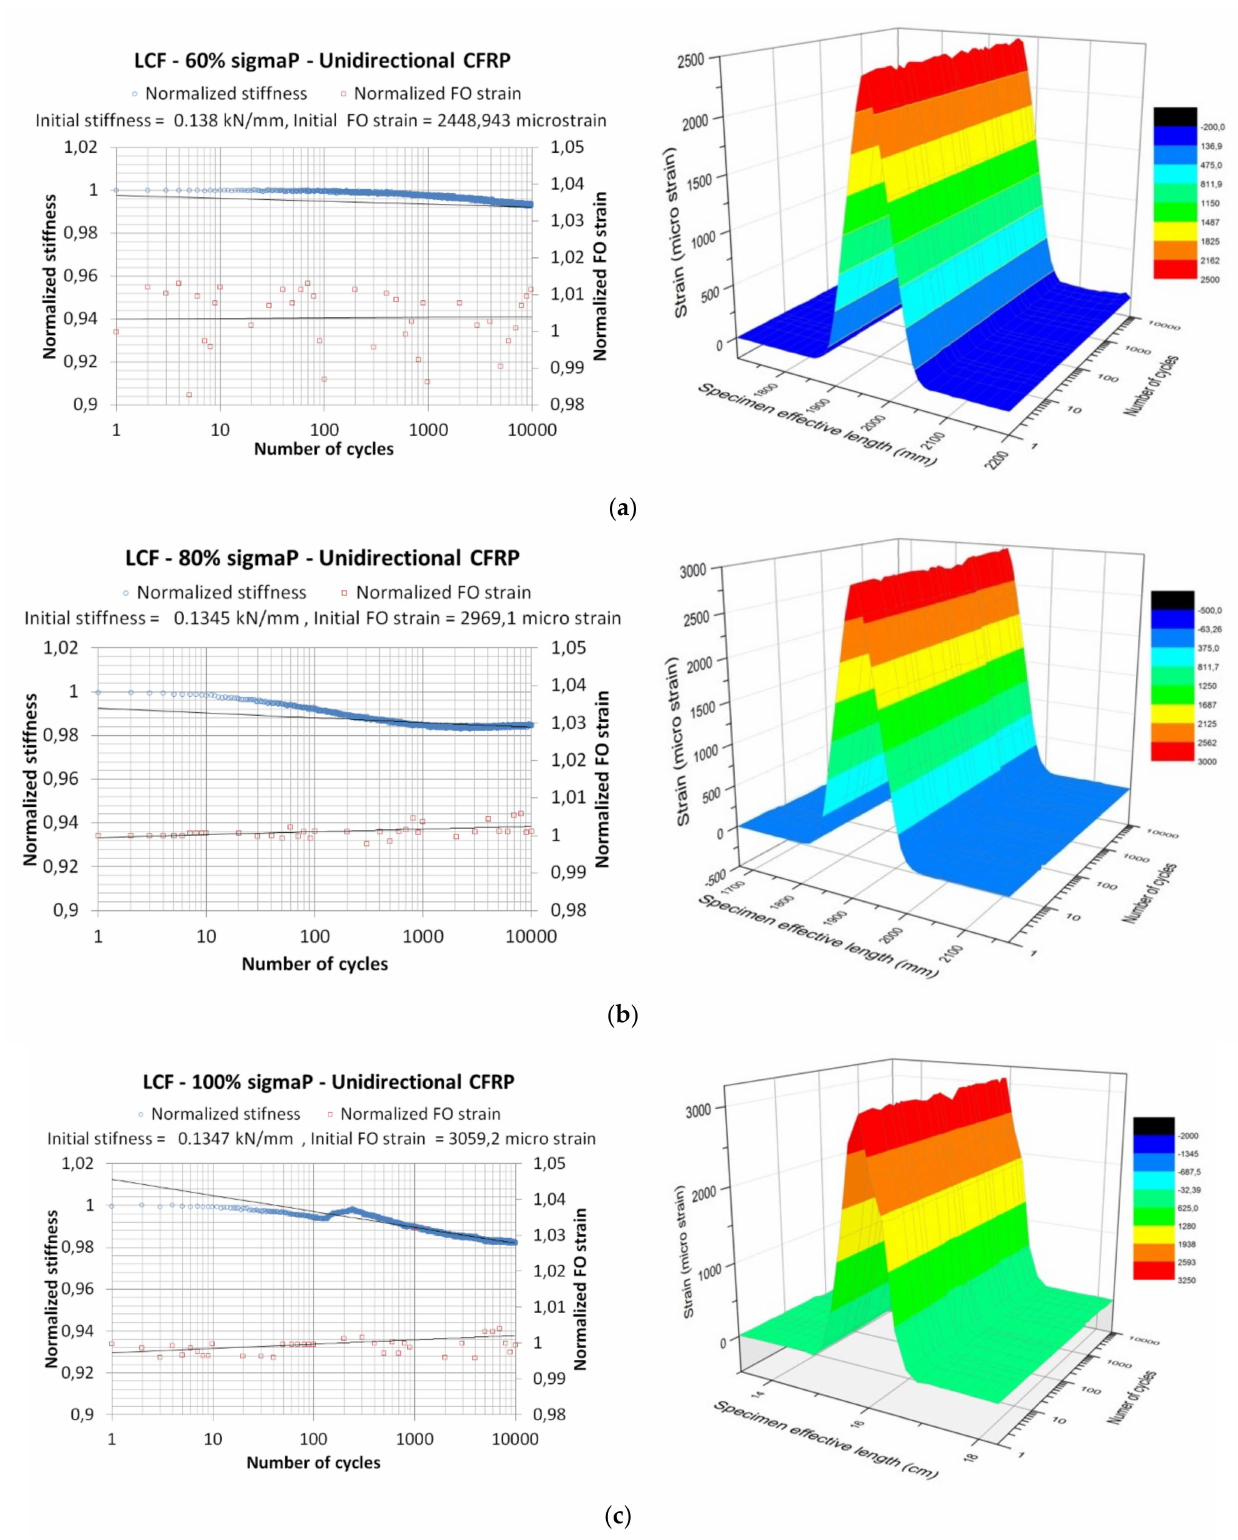
Figure 20. LCF test and associated 3D profile curves of the ( a ) 0.6 σ p, ( b ) 0.8 σ p, and ( c ) 1.0 σ p maximum applied stress of UD smart